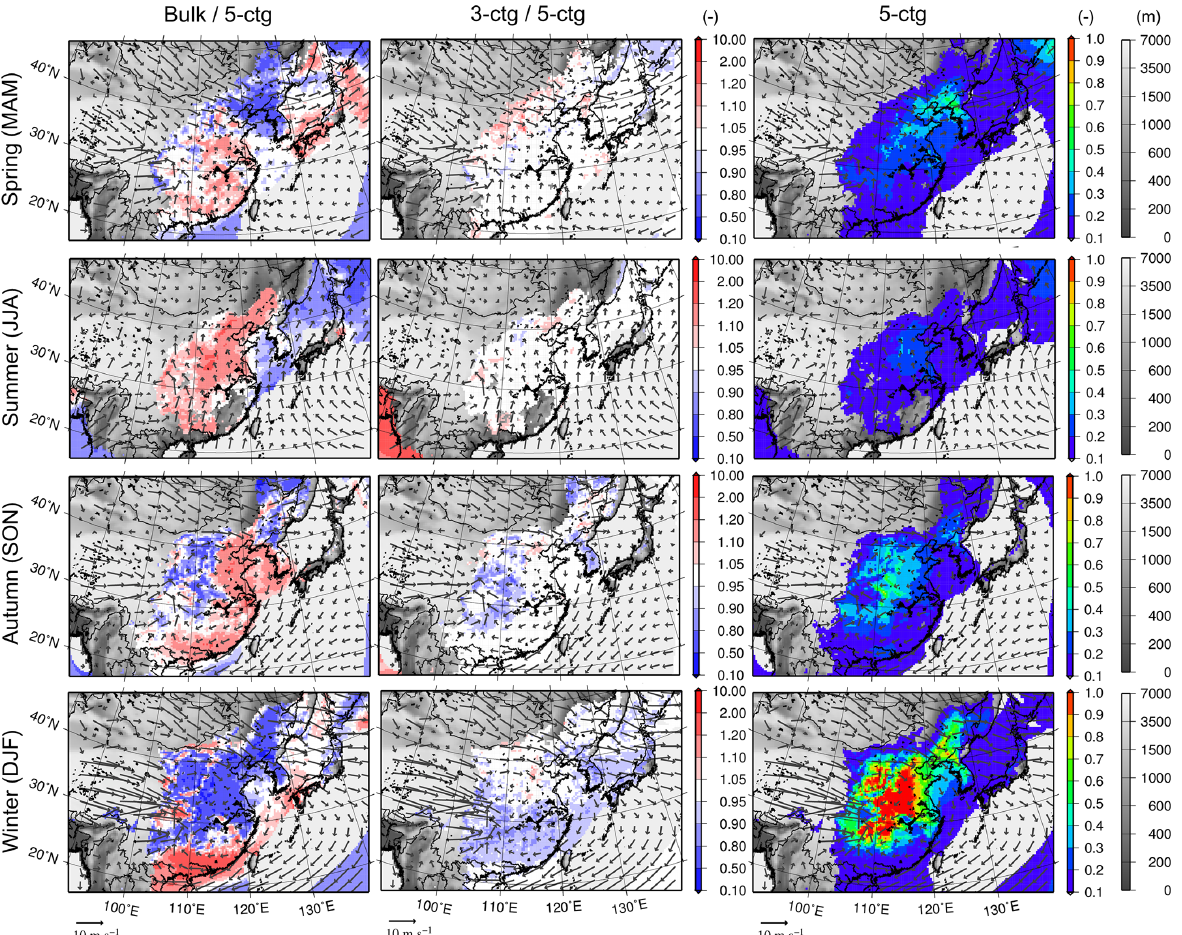
Figure 8. Same as Figs. 3–7 but for AOT (at 500nm) below approximately 1kma.g.l. The wind vectors are also averaged within